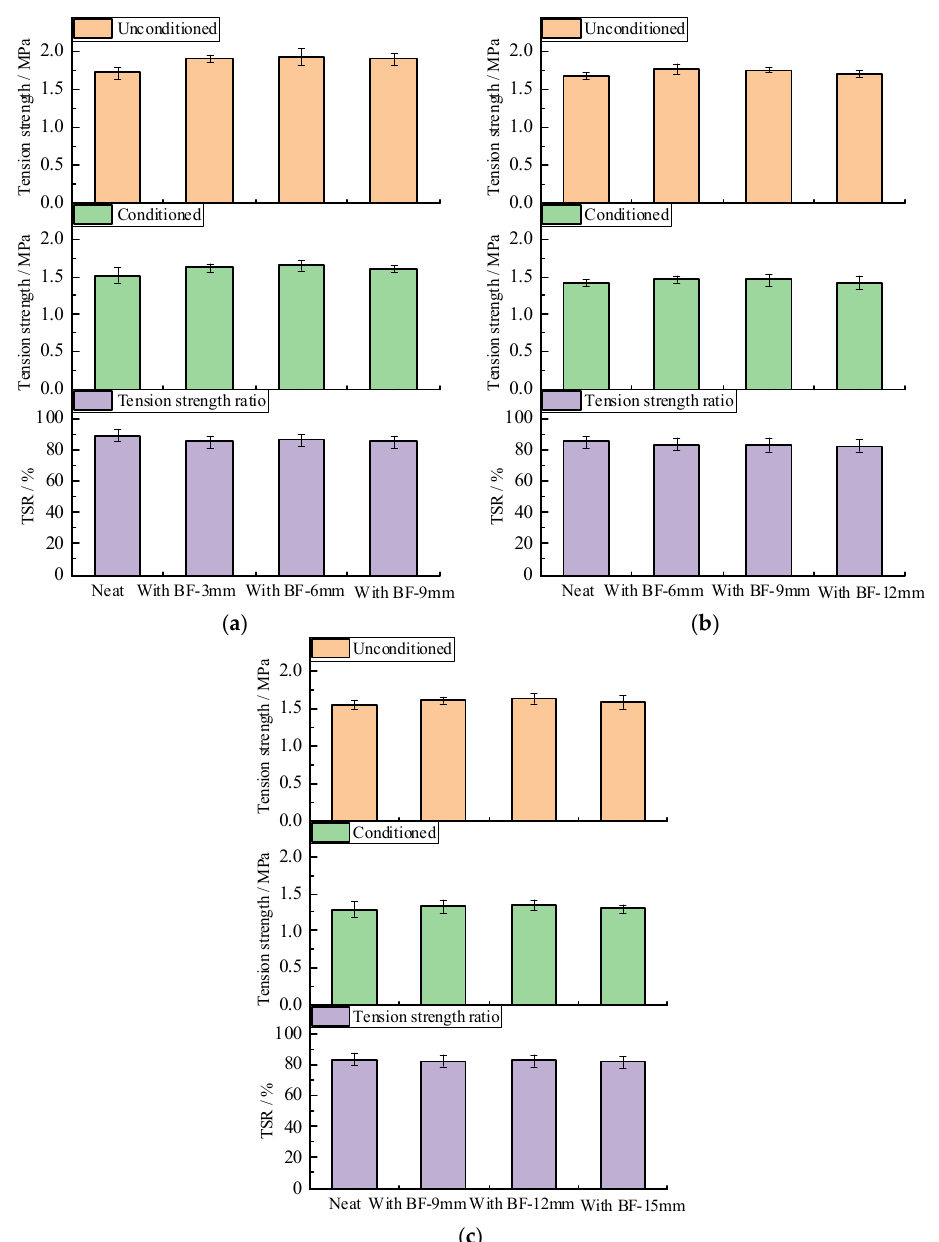
Figure 10. Freeze-thaw splitting test results: ( a ) SUP-13; ( b ) SUP-20; and ( c ) SUP-25.